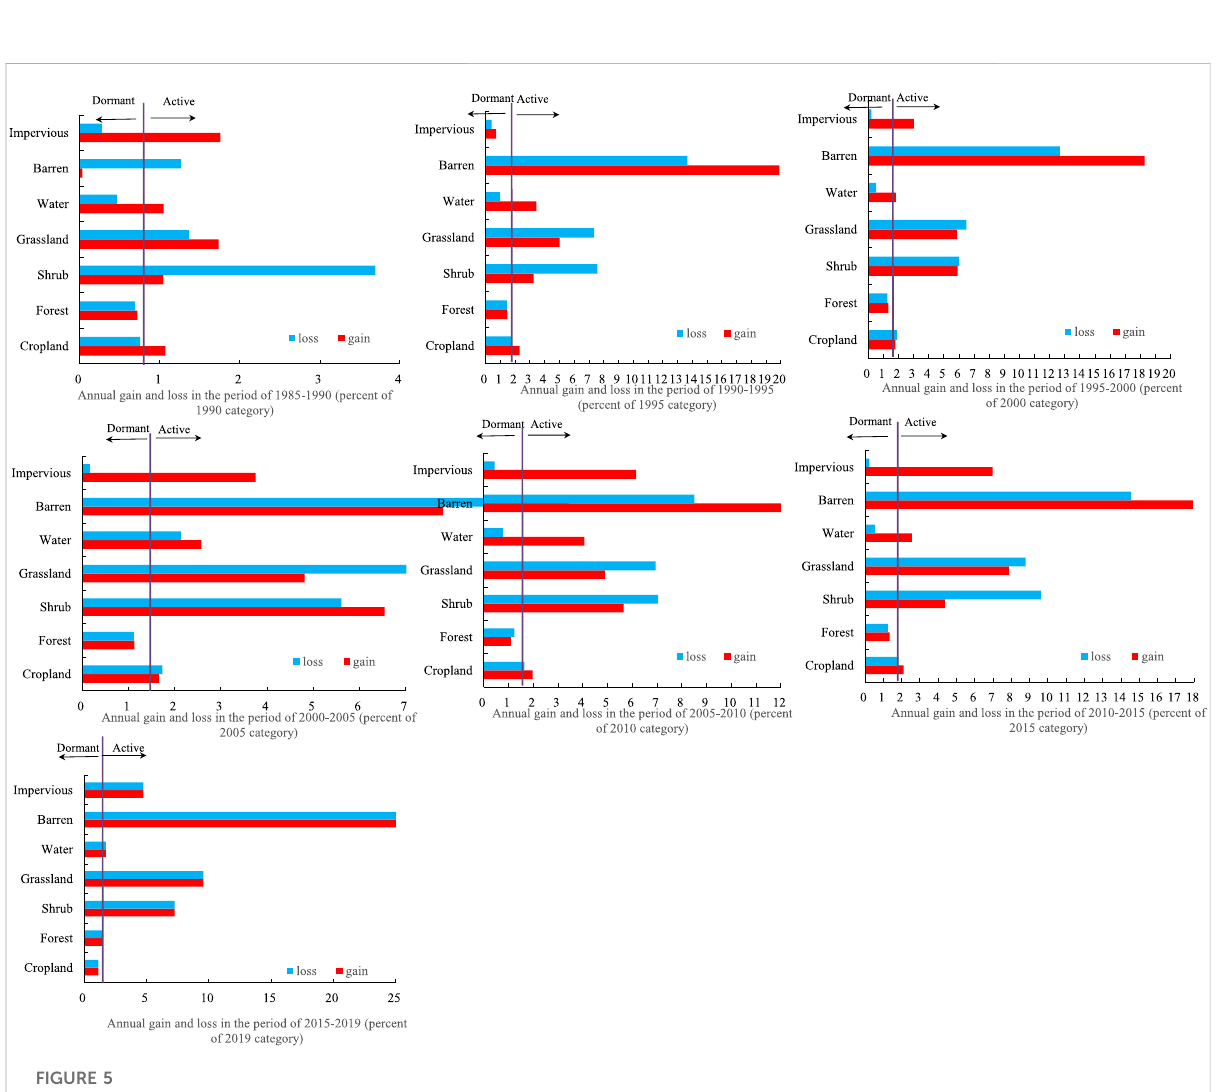
FIGURE 5 Intensity changes of land use in category level in Wujiang River